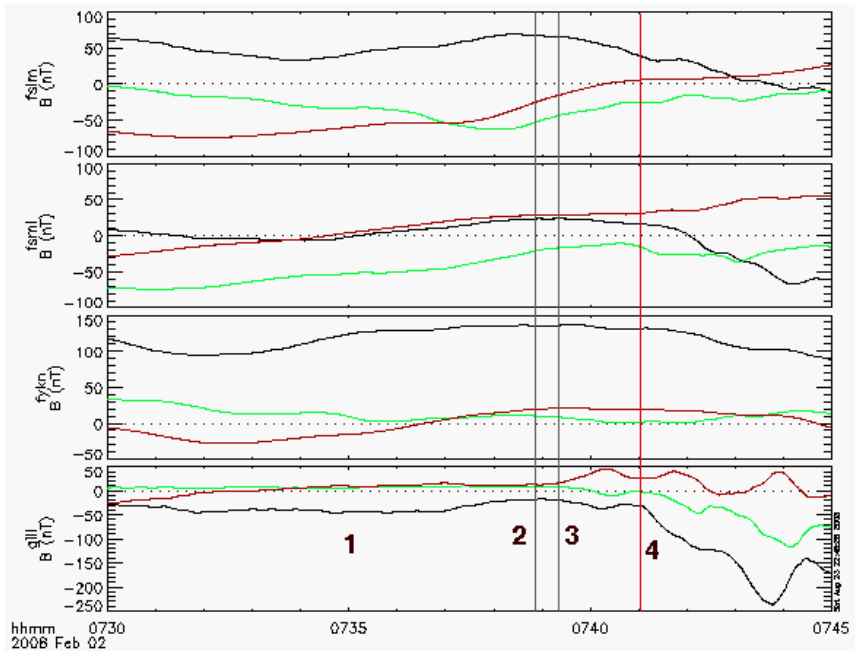
Figure 8. The ground based magnetometer components, B x , B y and B z (black, green and red) in full 0.5 sec time resolution from Fort Simpson, Fort Smith, Fort Yukon and Gillam. The vertical bars represent the times identified in Figure 6